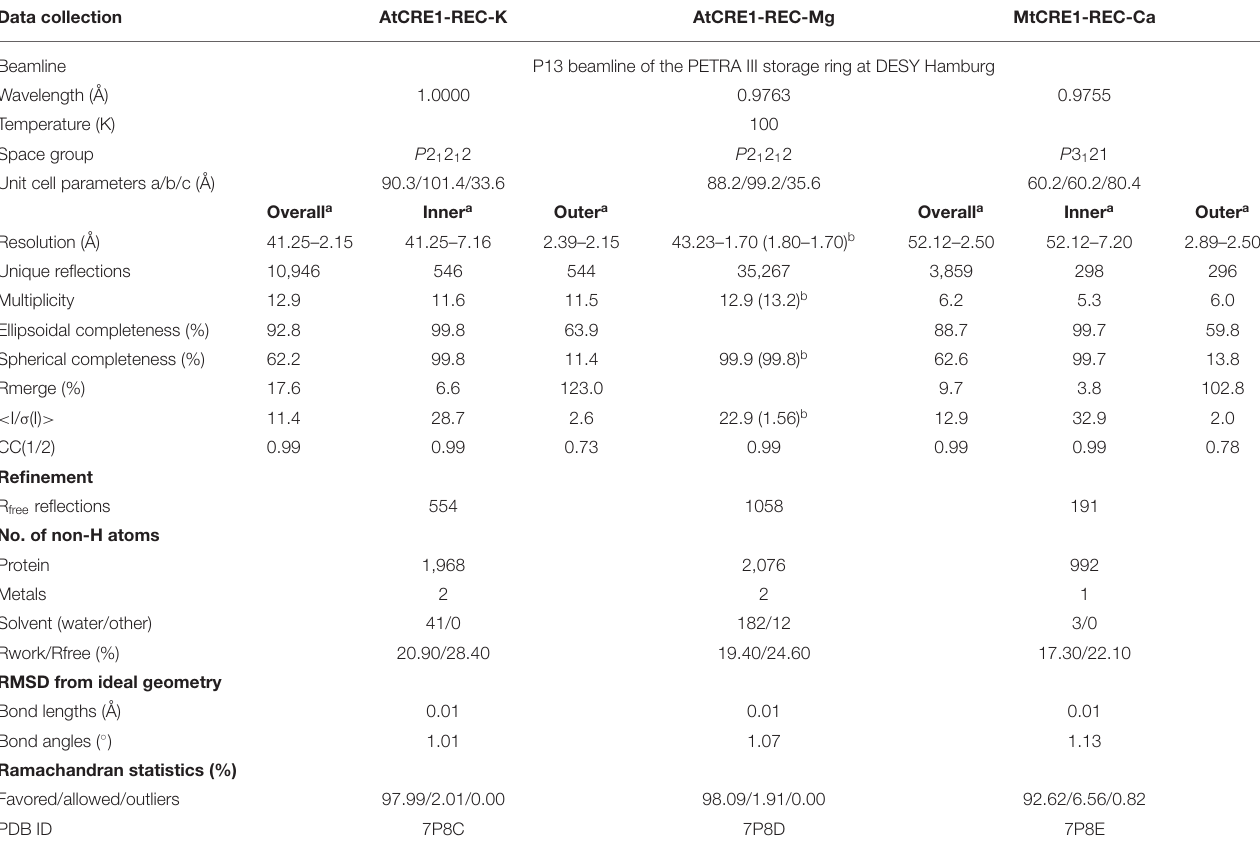
TABLE 1 | Diffraction data and refinement